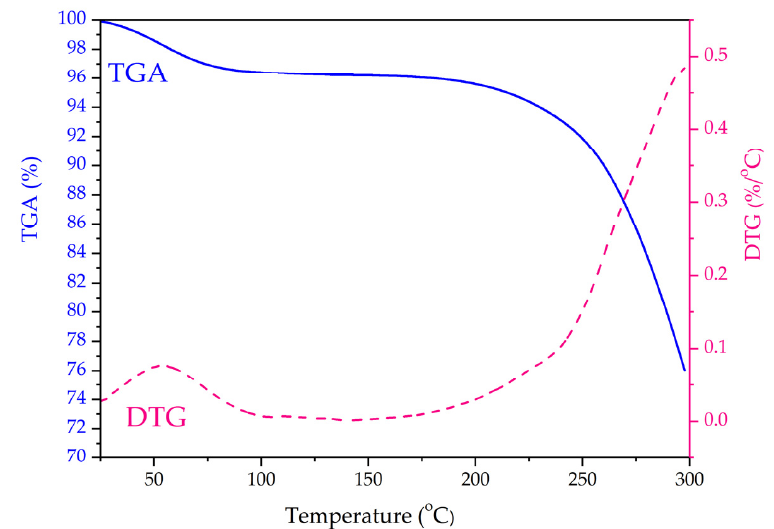
Figure 3. TGA–DTA curve of S. holocarpa